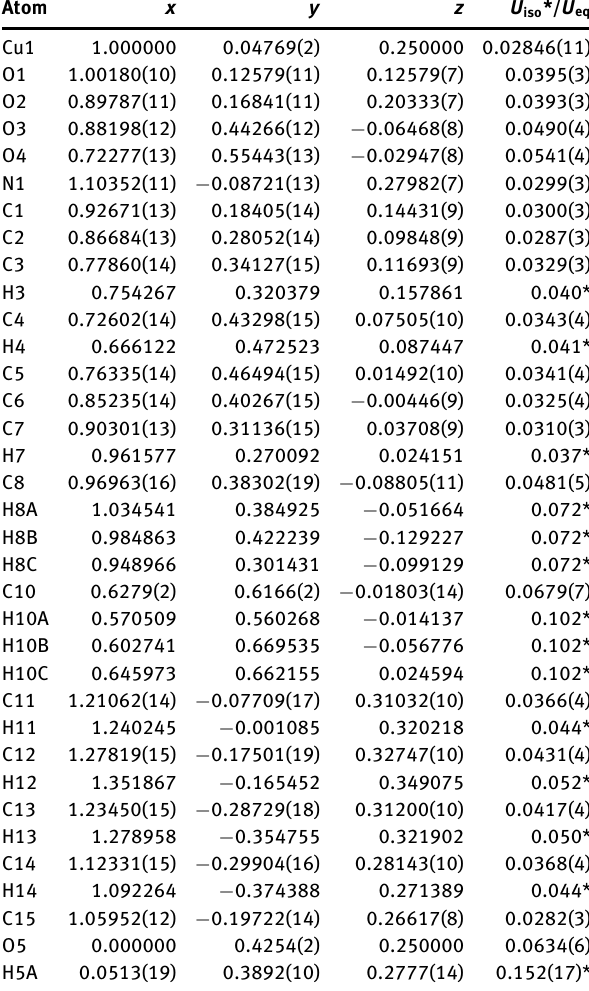
Table 2: Fractional atomic coordinates and isotropic or equivalent isotropic displacement parameters (Å 2